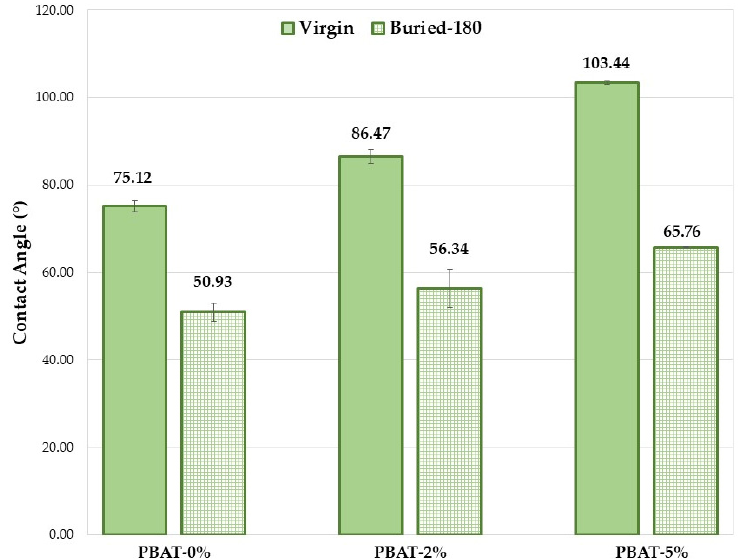
Figure 4. Average static contact angle values for the PBAT film samples (180 days).